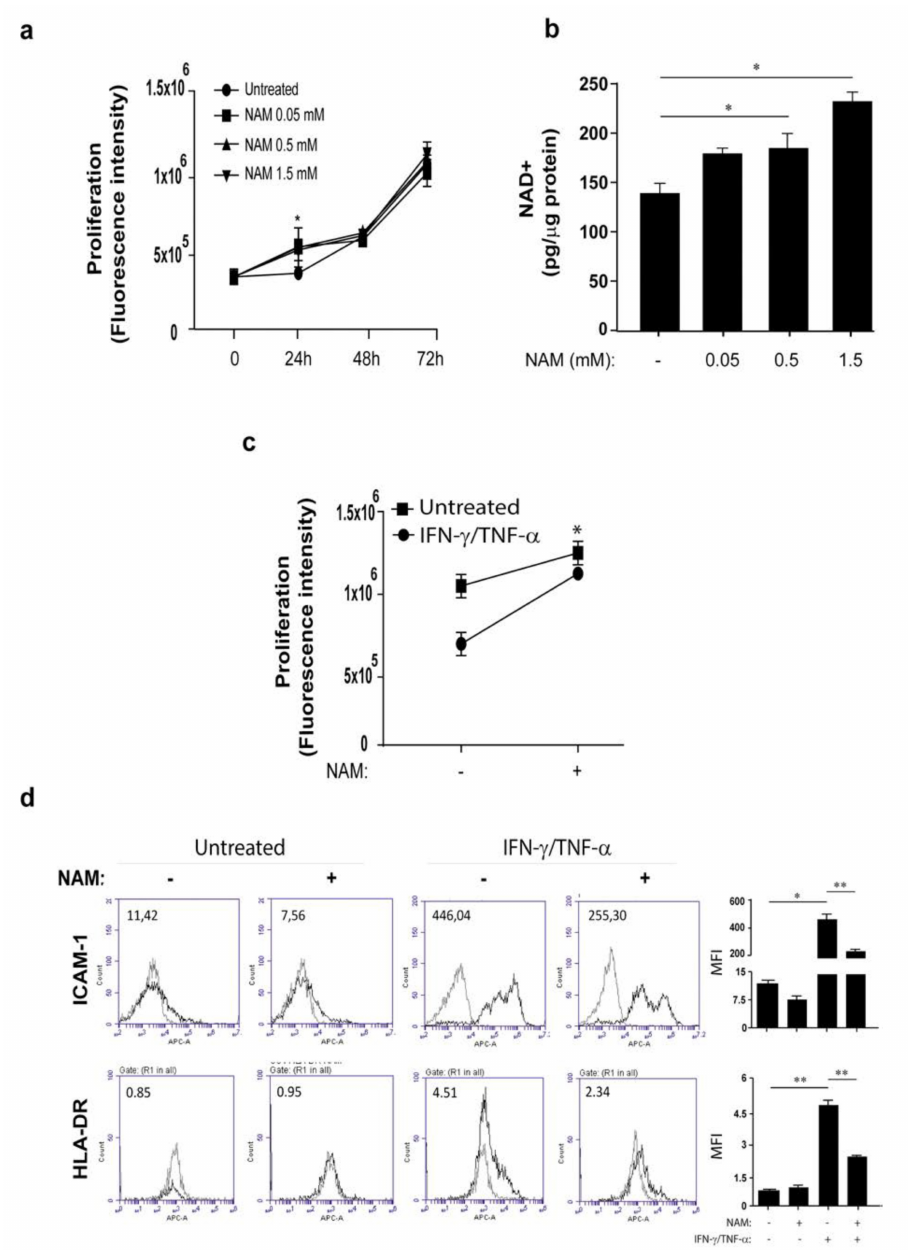
Figure 5. NAM induces proliferation of human fibroblasts and reduces IFN- γ /TNF- α -induced adhesion membrane molecule expression. ( a ) Cell proliferation was evaluated by CyQUANT assay on primary cultures of human fibroblasts in DMEM deprived of serum and left untreated or treated with increasing doses of NAM (0.05–1.5 mM) for 24, 48, and 72 h. ( b ) NAD + levels were quantified in fibroblast cultures treated with increasing NAM doses by colorimetric assay and expressed as mean of pg/ µ g of total proteins. ( c ) Cell proliferation was evaluated in fibroblasts left untreated or stimulated with IFN- γ (200 U/mL)/TNF- α (50 ng/mL) in presence or absence of NAM (1.5 mM) for 24 h. In ( a , c ), data are shown as the mean of fluorescence intensity values obtained from three independent experiments ± SD carried out on n = 3 different strains. In ( b ) NAD + levels were quantified by colorimetric assay and expressed as mean of pg/ µ g of total proteins. All data shown are the mean of three different experiments ± SD. In ( a – c ), * p ≤ 0.05 by paired Student’s t test. ( d ) ICAM-1 and HLA-DR expression was evaluated by flow cytometry analysis on fibroblasts stimulated for 24 h by IFN- γ /TNF- α and treated with NAM (1.5 mM). Data are shown as means of fluorescence intensity (MFI). All data shown are the mean of three different experiments ± SD. * p ≤ 0.05 and ** p ≤ 0.01, as assessed by paired Student’s t